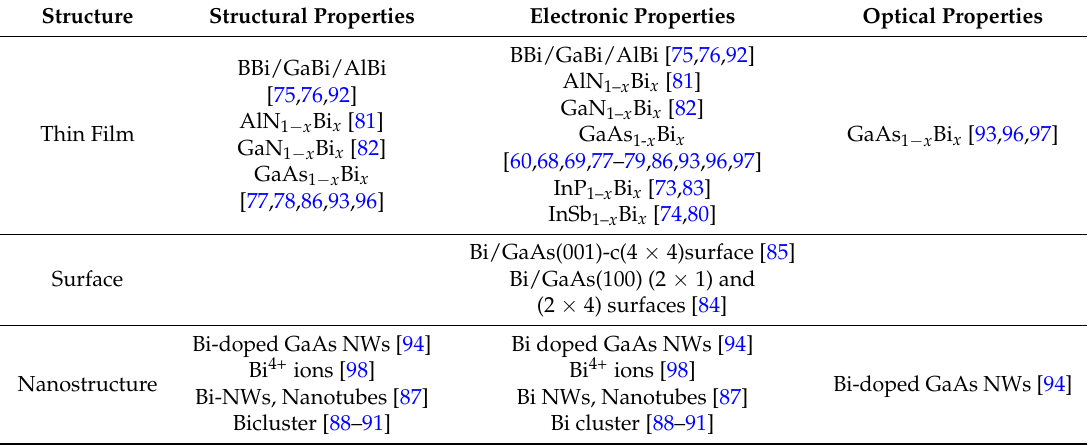
Table 2. Summary of the first-principles method used for predicting properties in III-V